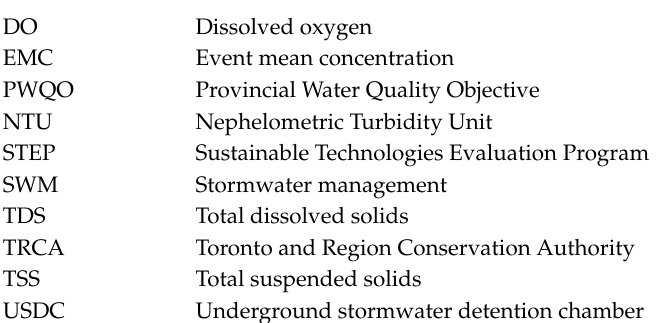
Table S1: Water quality statistical analysis